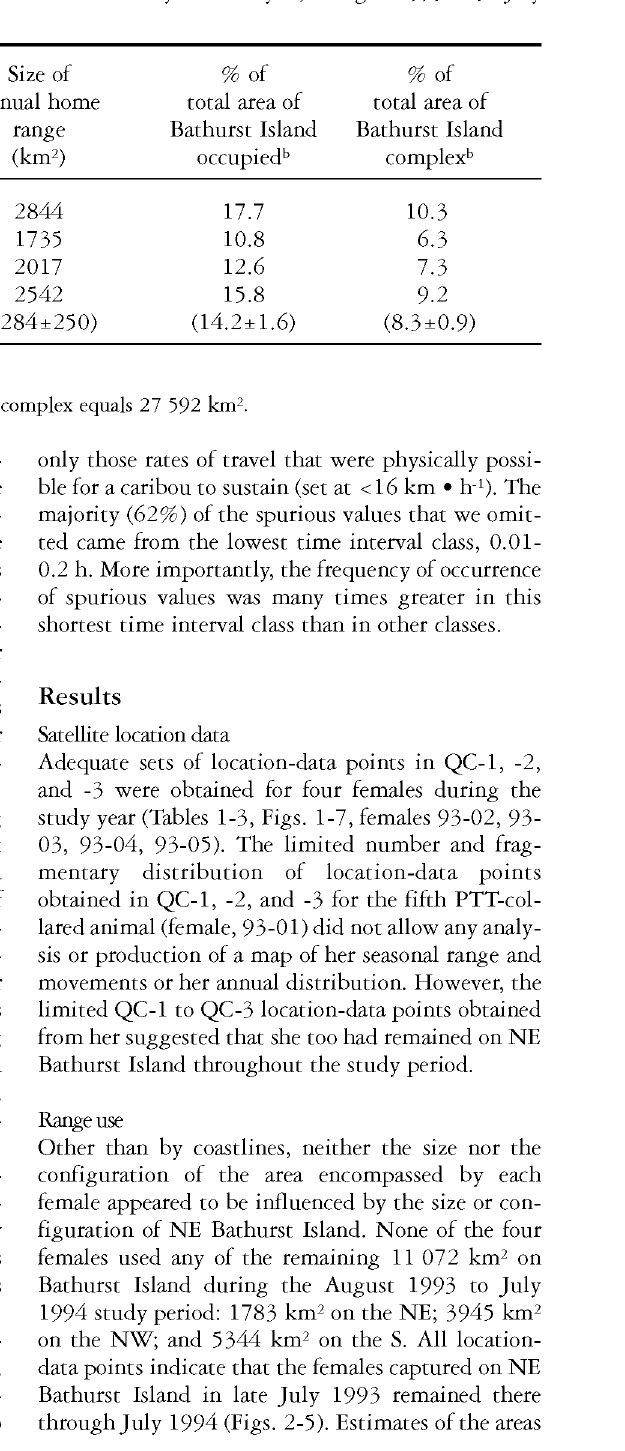
Table 1. Approximation of annual size of areas encompassed by perimeter locations and associated relevant land statis tics for four female Peary caribou, Bathurst Island, Canadian High Arctic: based on connection of satellite perimeter location-data points obtained during an environmentally favorable year, 1 August 1993 to 31 July